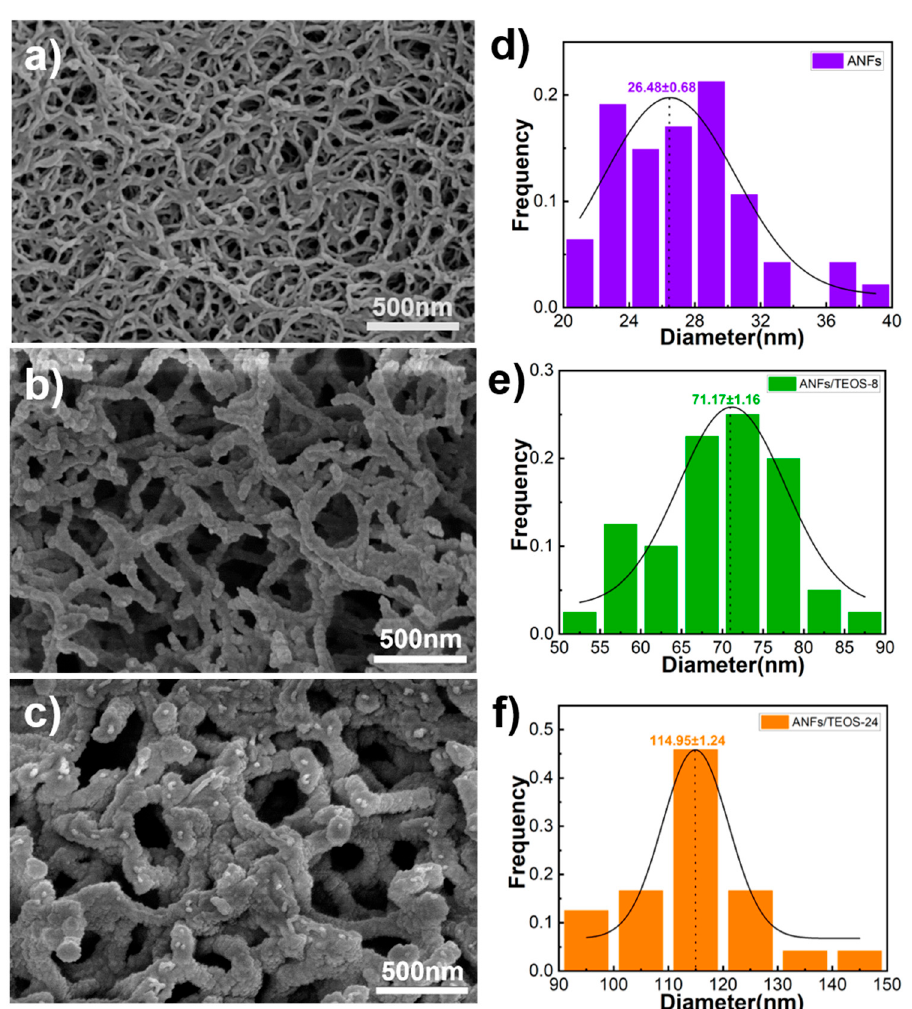
Figure 2. SEM images of ANFs aerogels ( a ), aramid fibers@silica aerogel prepared by CVD 8 h, ( b ) and 24 h ( c ), together with the histograms of the corresponding nanofibers ( d – f ), respectively.